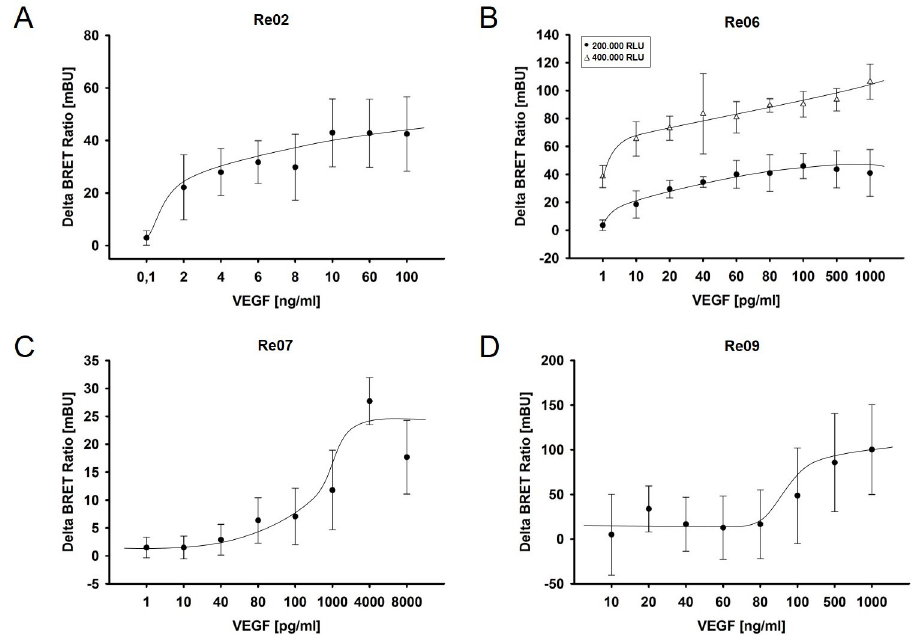
Fig 4. VEGF dependent Delta eBRET2 Ratios of the four biosensors Re02 (A), Re06 (B), Re07 (C) and Re09 (D). Biosensor concentrations in cell lysates were adjusted on the basis of RLuc8 expression to 200,000 RLU and 400,000 RLU. Lysates were incubated with individually adjusted VEGF concentrations and Delta eBRET2 Ratios were calculated. Significance defined as p <